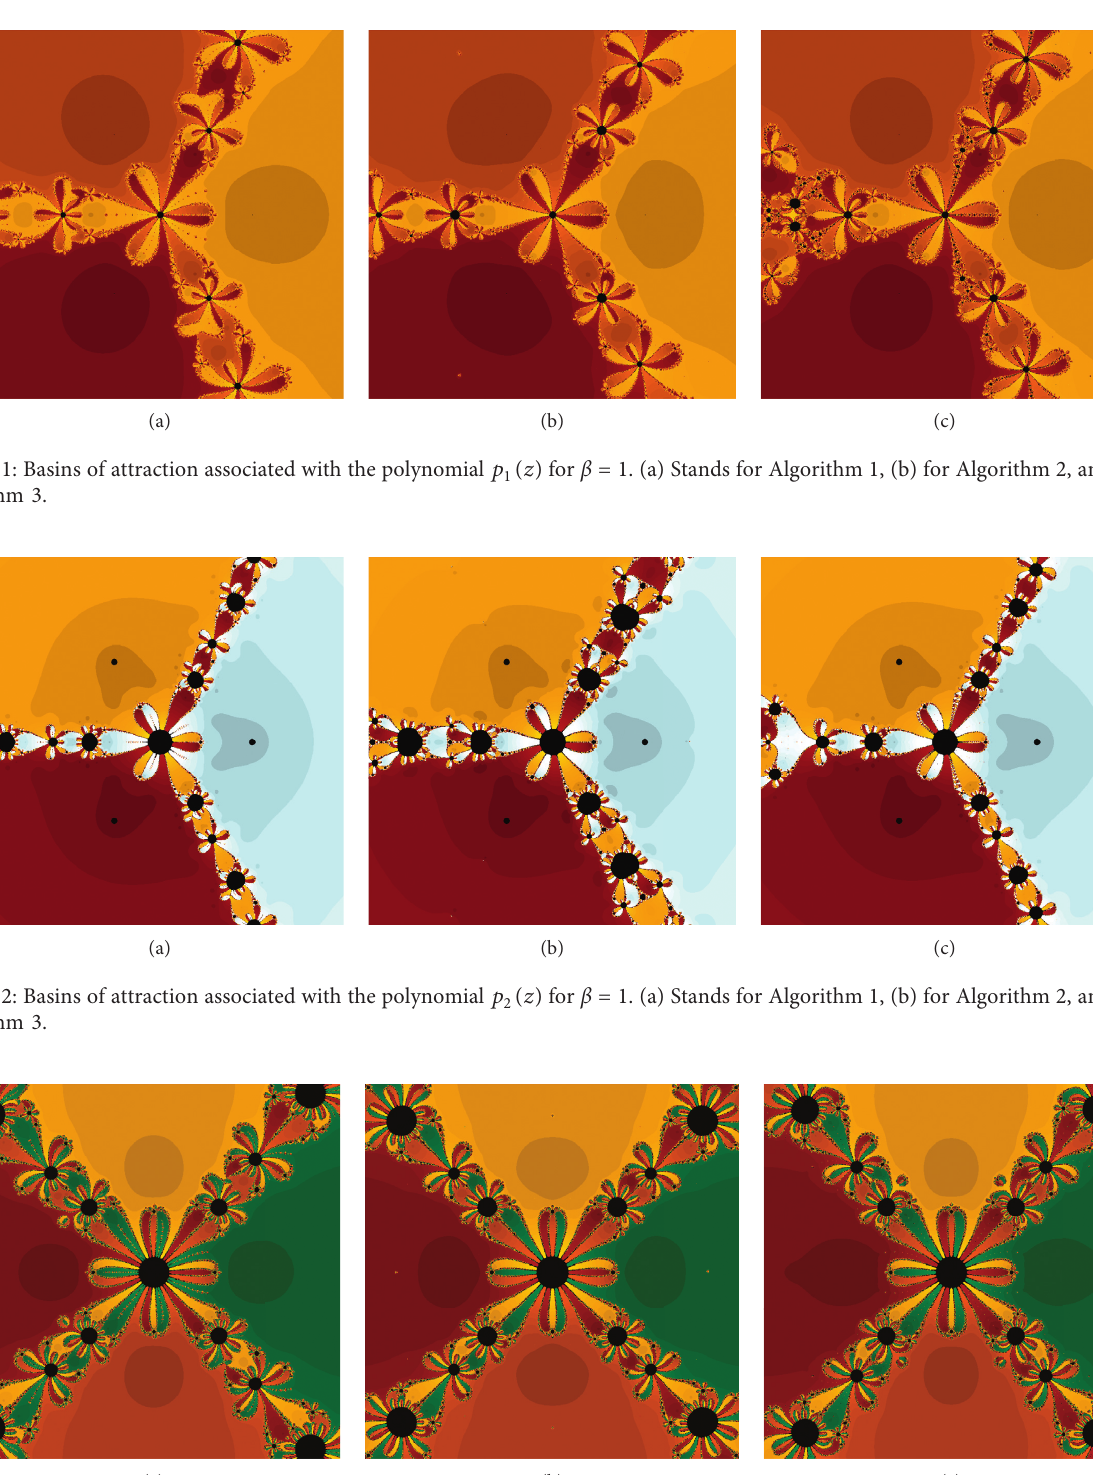
( z ) for β � 1. (a) Stands for Algorithm 1, (b) for Algorithm 2, and (c) for 3